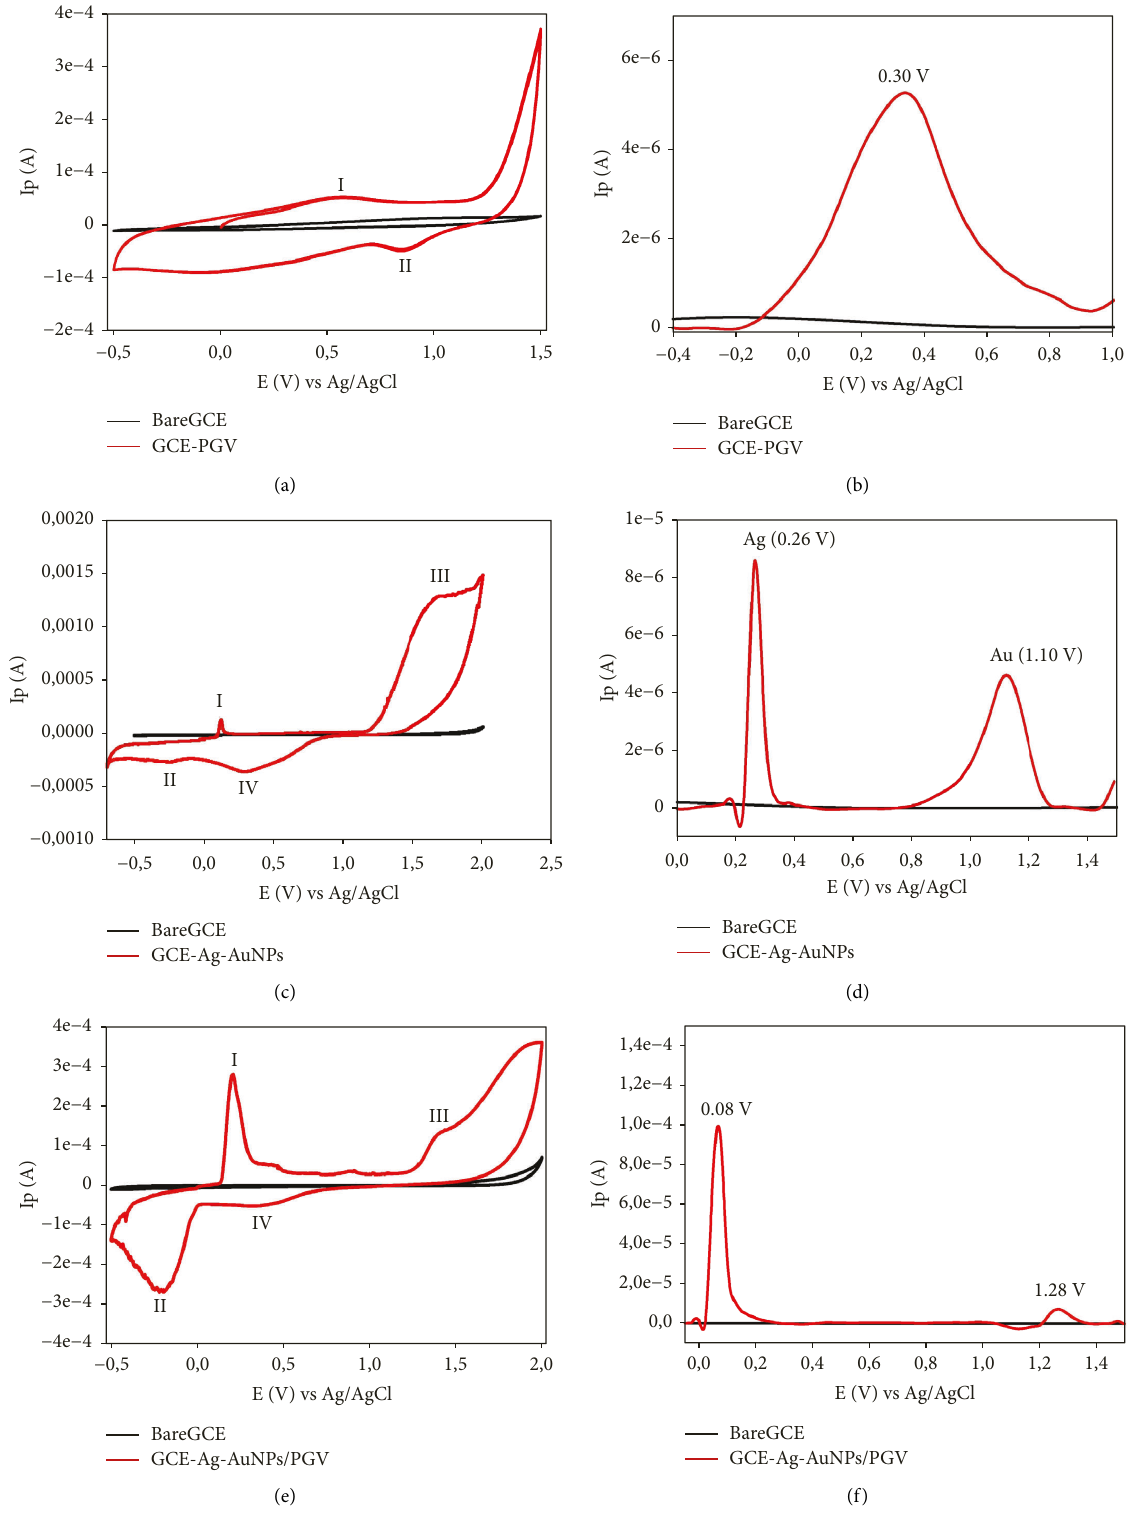
Figure 3: CV and DPV voltammetric data of PGV bentonite (a, b), Ag-AuNPs (c, d), and Ag-AuNPs/PGV (e, f) bentonite depicting the difference in electrochemical behavior caused by bentonite functionalization obtained in the 0.1 M HCl supporting electrolyte at a CV scan rate of 70mv/s, and 0.035V and 15s DPV pulse amplitude and condition time,